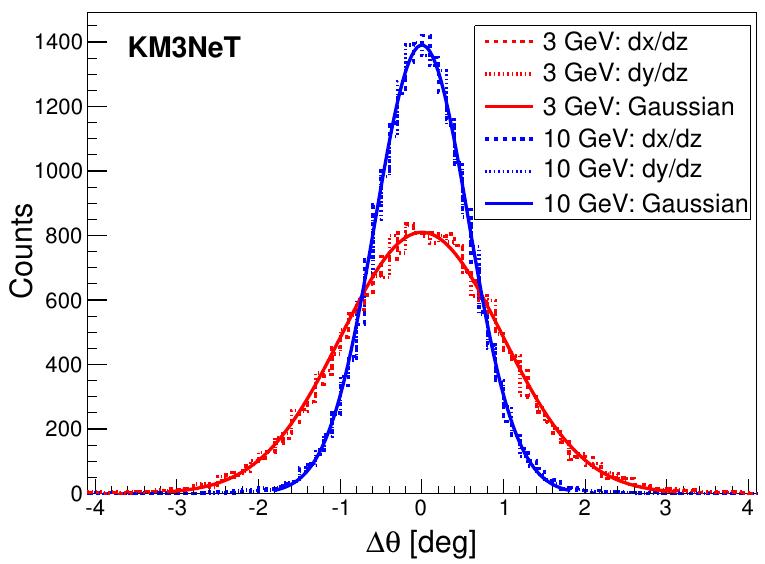
Figure 23 . Distributions of the slopes d x /d z (dashed) and d y /d z (dotted) from (cid:12)ts to muons which began traveling along the z -axis with an initial energy of 3 GeV (red) and 10 GeV (blue). Gaussian (cid:12)ts (solid) are also